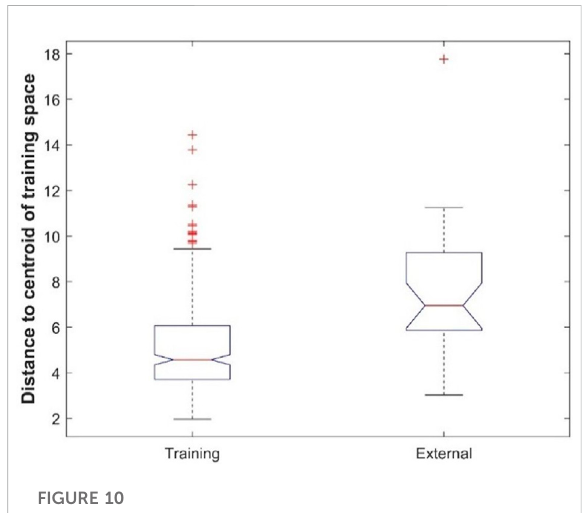
FIGURE 10 Boxplot of distances to the centroid of training chemicals for the training dataset and external validation